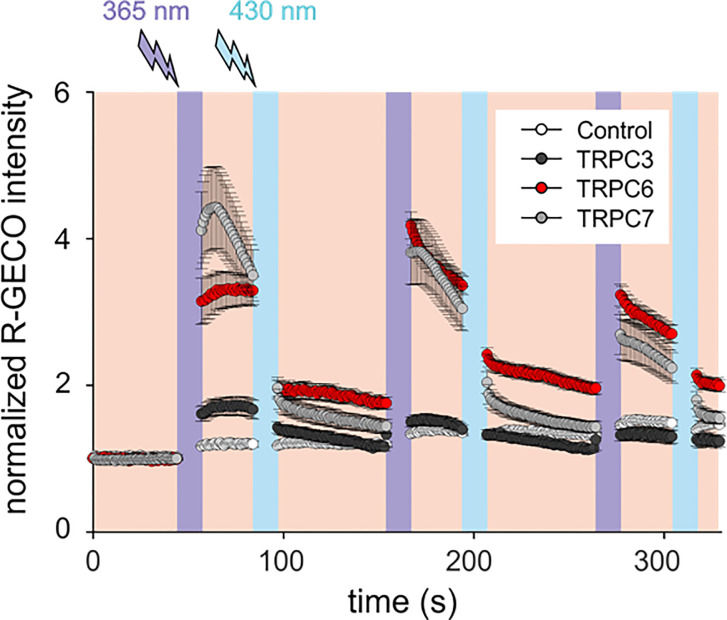
OptoBI-1 photocycling induced Ca2+ signaling triggered by overexpressed TRPC3, TRPC6 or TRPC7 channels in RBL-2H3 cells. Comparison of responses in cells overexpressing YFP-TRPC3, YFP-TRPC6 or TRPC7-CFP together with R-GECO as a Ca2+ reporter. Cells expressing R-GECO was only used as a control. Time courses (mean ± SEM) of R-GECO fluorescence intensity (red, 577 nm) during photoactivation of TRPC3 (black, n = 8 cells), TRPC6 (red, n = 23 cells), TRPC7 (gray, n = 21 cells), and controls (white, n = 10 cells). Cis-trans OptoBI-1 photocycling was repeated three times, by illuminating cells with UV (365 nm, 10 s; violet) followed by blue light (430 nm, 10 s, blue).